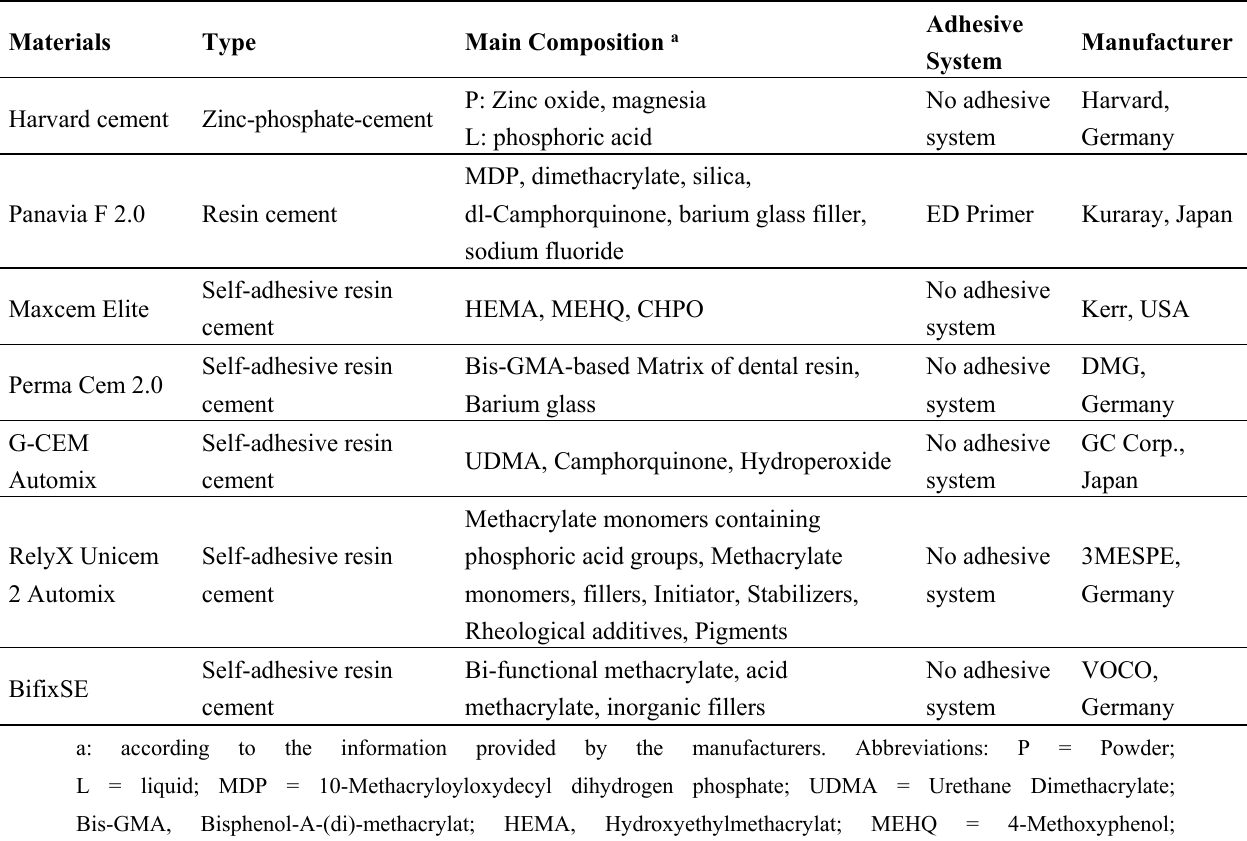
Table 1. Description of the luting agents used in this